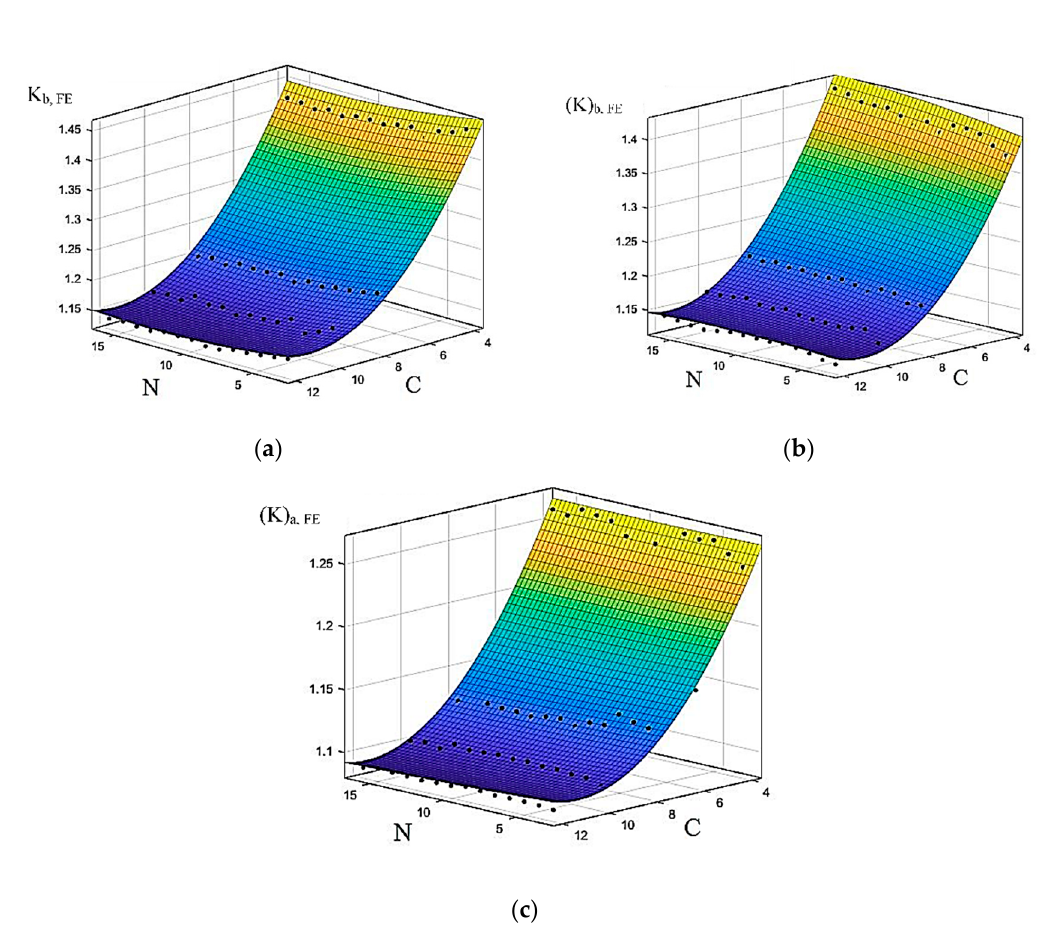
Figure 11. Surface plot based on SLA results for ( a ) K_(b,FE), ( b ) (K)_(b,FE) and ( c ) (K)_(a,FE).